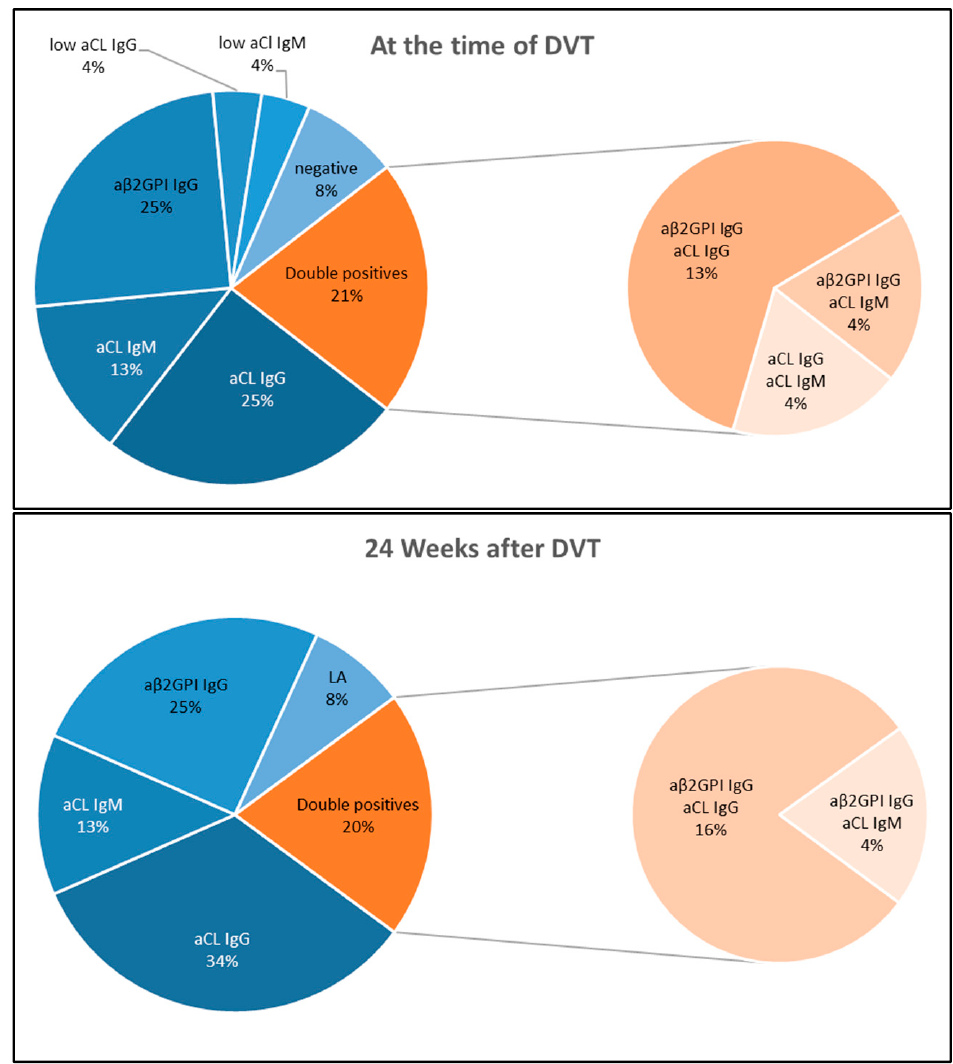
Figure 2. aPL profile of APS patients ( n = 24) at the time of acute DVT (upper panel) and 24 weeks after DVT (lower panel).